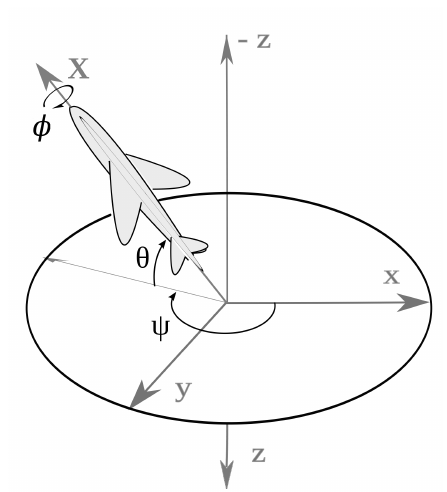
Figure 2. Axes and coordinate